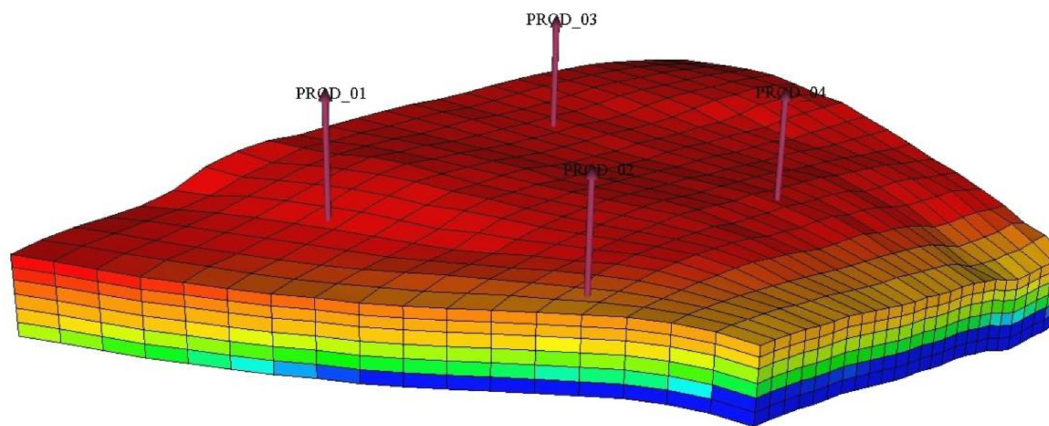
Fig. 3 Reservoir pressure and saturation pressure variations with